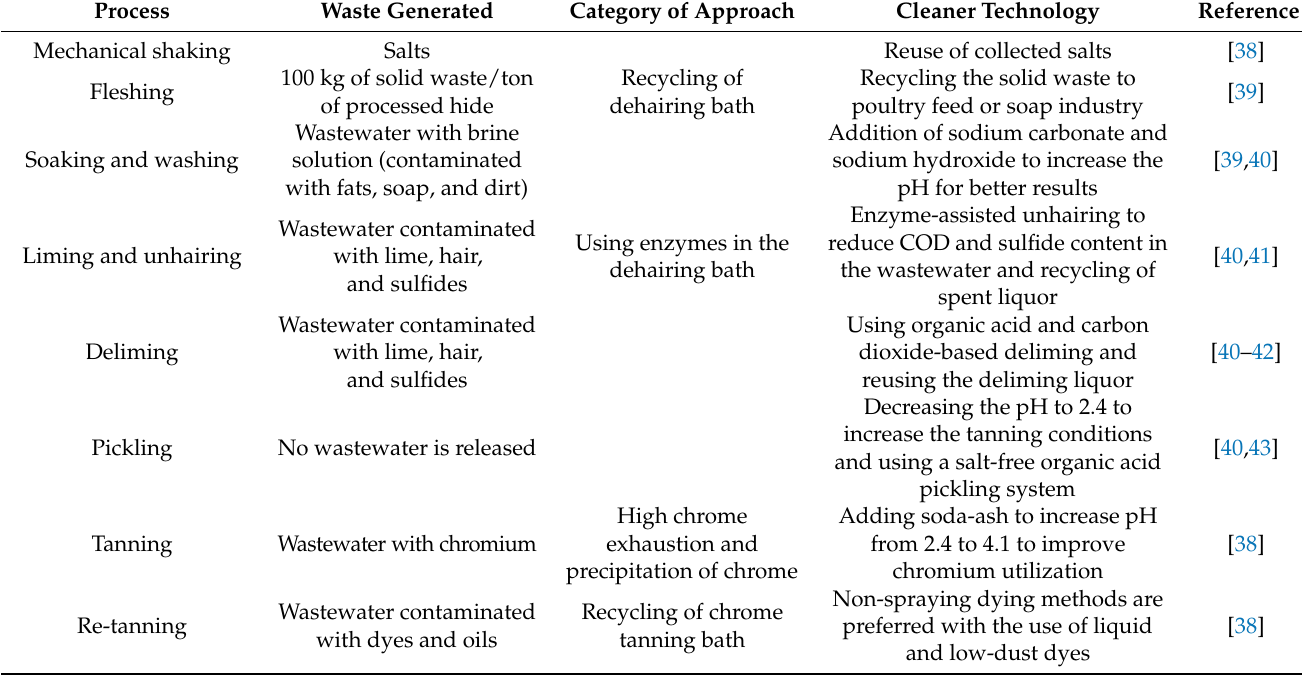
Table 1. Cleaner production approaches in the leather manufacturing